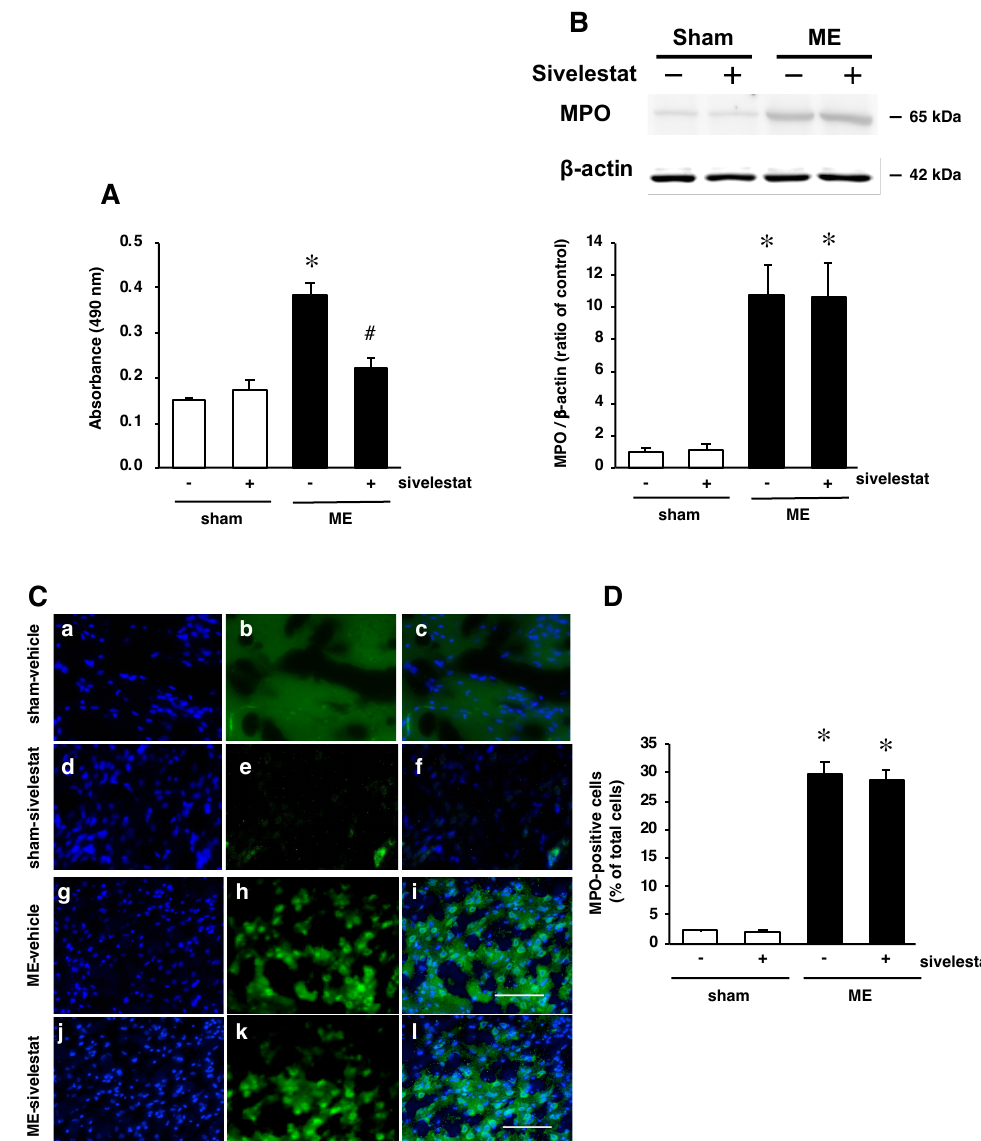
Figure 5. ( A ) Changes in tissue elastase activity in the vehicle-treated (-) sham and ME groups and sivelestat-treated (+) sham and ME groups on day 1 after surgery. * Significant difference from the vehicle-treated sham group ( p < 0.05). # Significant difference from the vehicle-treated ME group ( p < 0.05). Each value represents the mean ± SD of 6 animals; ( B ) Levels of myeloperoxidase (MPO) protein in the vehicle-treated (-) sham and ME groups and sivelestat-treated (+) sham and ME groups on day 1 after surgery. Bands corresponding to MPO were scanned, and the scanned band was normalized by β-actin on the same blot. The results are expressed as the mean ratio of the non-operated (control) group ± SD ( n = 8 each). *Significant difference from the sham group ( p < 0.05); ( C ) Images of double staining (merge, c, f, i, and l) with Hoechst 33342 (blue, a, d, g, and j) and MPO (green, b, e, h, and k) for the vehicle-treated sham and ME groups and sivelestat-treated sham and ME groups on day 1 after surgery. The scale bar represents 100 µm; ( D ) The number of MPO-positive cells in the vehicle-treated (-) sham and ME groups and sivelestat-treated (+) sham and ME groups on day 1 after surgery was counted. Five sections were made per animal, and 266–722 cells were counted per section, and the average of 5 sections per animal was calculated. The values for MPO-positive cells are presented as the mean ± SD ( n = 5 each). * Significant difference from the sham group ( p < 0.05).